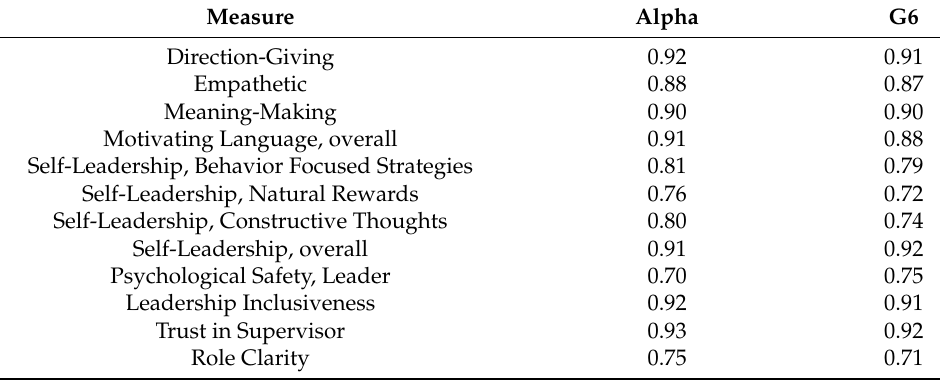
Table 1. Study Measure Reliabilities.